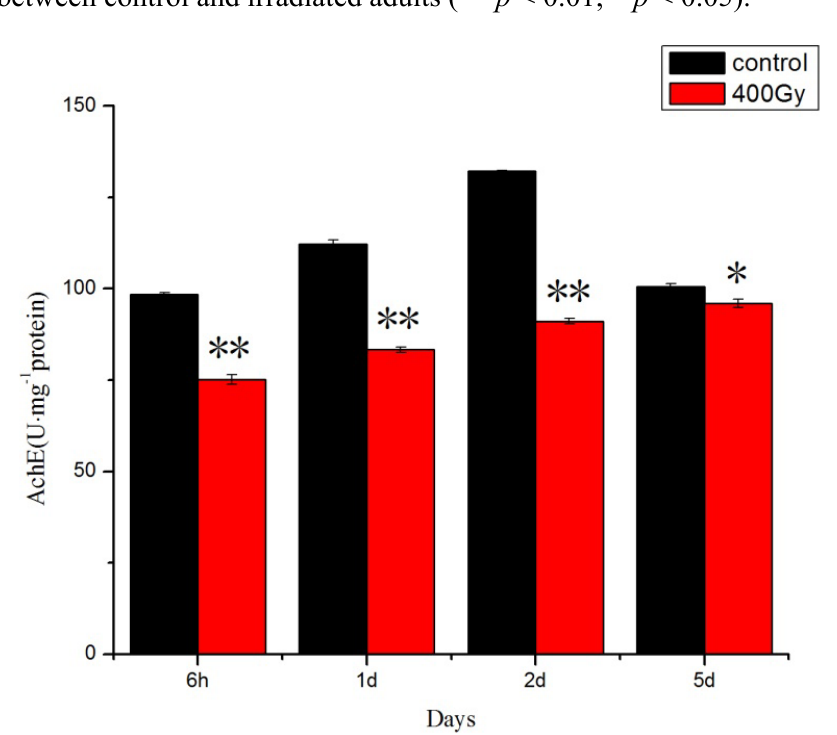
Figure 5. Effects of 60 Co- γ irradiation on AchE activity of P. citri adults for different lengths of time. Values are mean ± SD ( n = 3). Asterisk designates statistically significant difference between control and irradiated adults (** p < 0.01; * p <